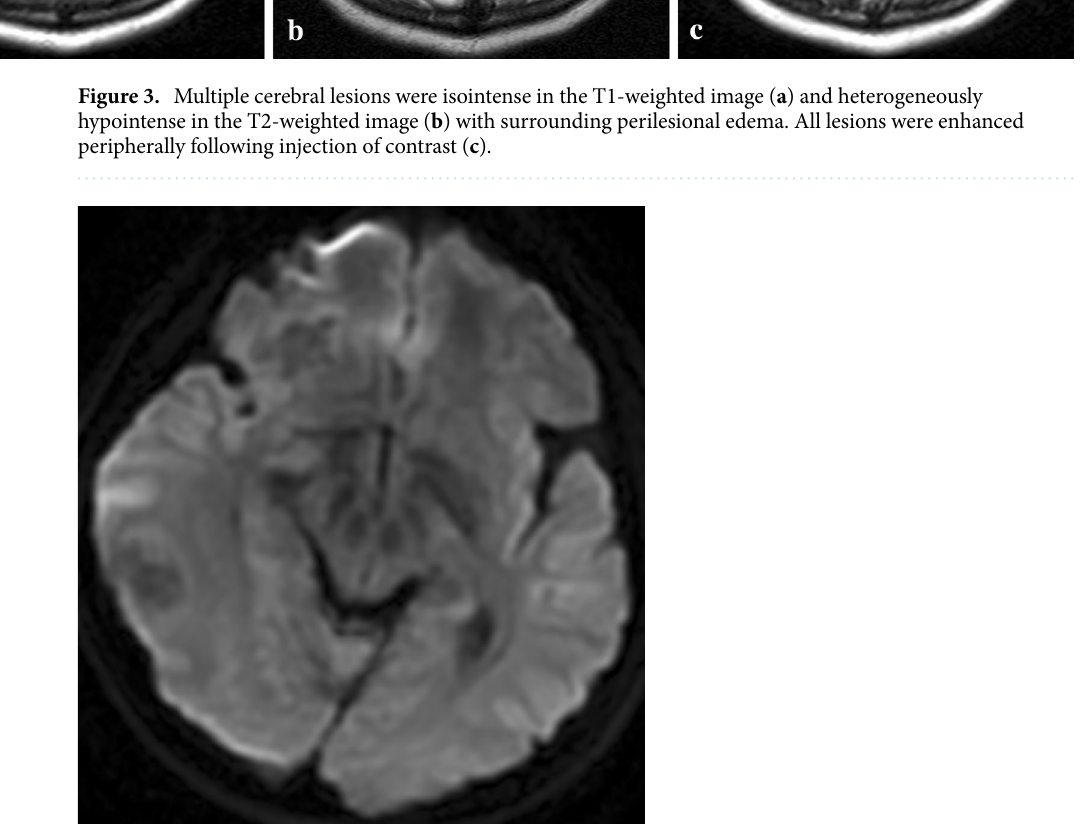
Figure 4. Two lesions were hyperintense signal on a axial MR DWI